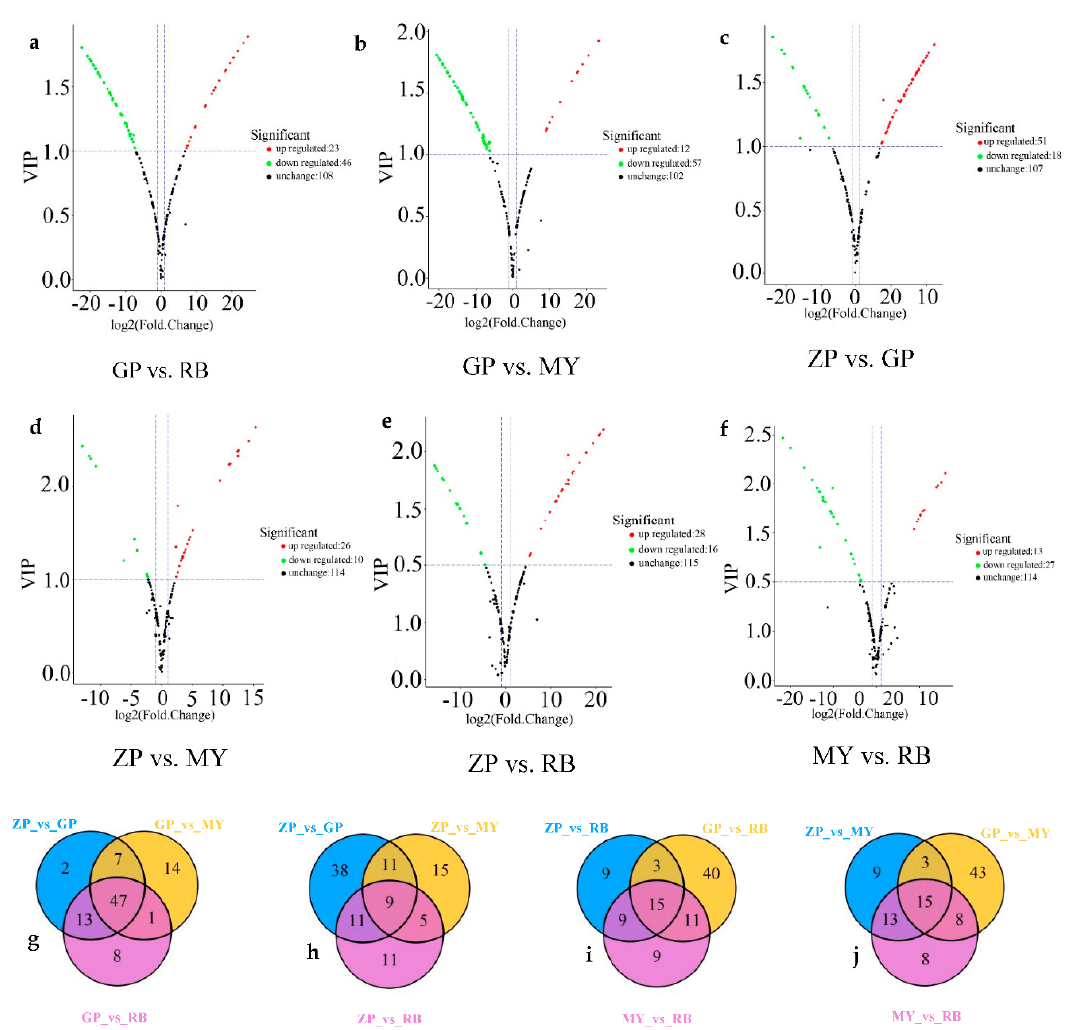
Figure 5. Volcano plots and Venn diagrams of flavonoid metabolites. ( a – f ) are volcano plots of di ff erent comparison groups: ( a ) GP vs. RB; ( b ) GP vs. MY; ( c ) ZP vs. GP; ( d ) ZP vs. MY; ( e ) ZP vs. RB; ( f ) MY vs. RB. Each point represents a metabolite. The abscissa is the logarithmic value of the fold change of each metabolite between two samples, while the ordinate is the VIP (variable important in projection) value. The greater the absolute value of the abscissa, the greater the di ff erence in the level of the metabolite when comparing two samples. The green dots in the graph indicate metabolites with lower levels, while the red dots indicate flavonoid metabolites with higher levels. The black dots indicate the metabolites that can be detected in the sample but without significant di ff erences among samples. ( g – j ) Venn diagrams of di ff erential flavonoid metabolites in di ff erent comparison groups: ( g ) ZP vs. GP, GP vs. MY, GP vs. RB; ( h ) ZP vs. GP, ZP vs. MY, ZP vs. RB; ( i ) ZP vs. RB, GP vs. RB, MY vs. RB; ( j ) ZP vs. MY, GP vs. MY and MY vs. RB.